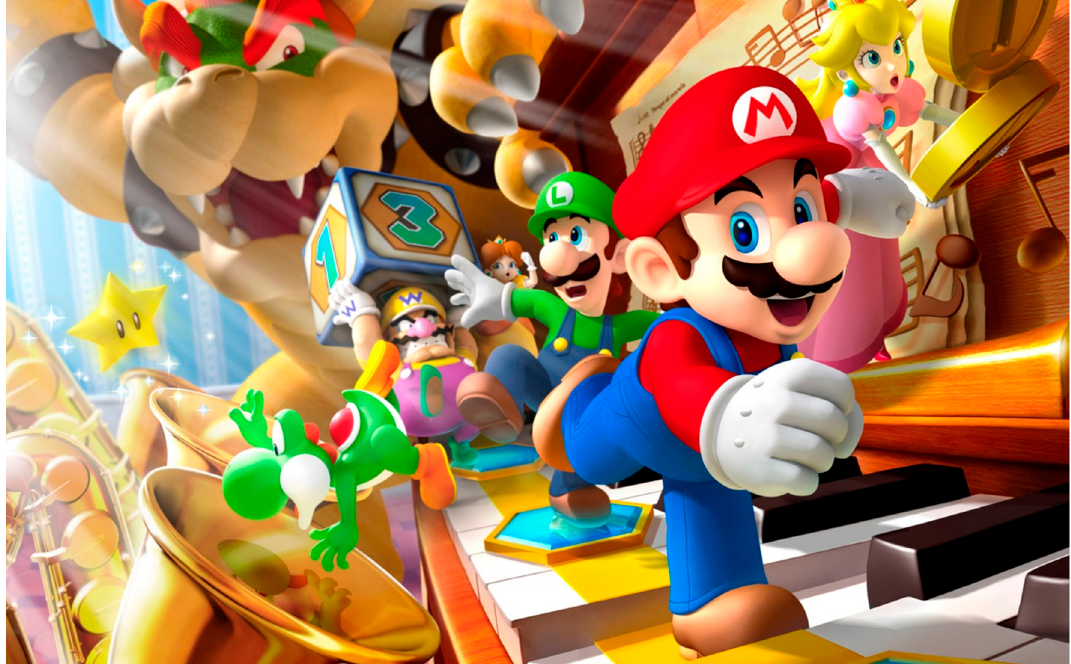
Figure 2. Super Mario, character created in 1985 and developed by